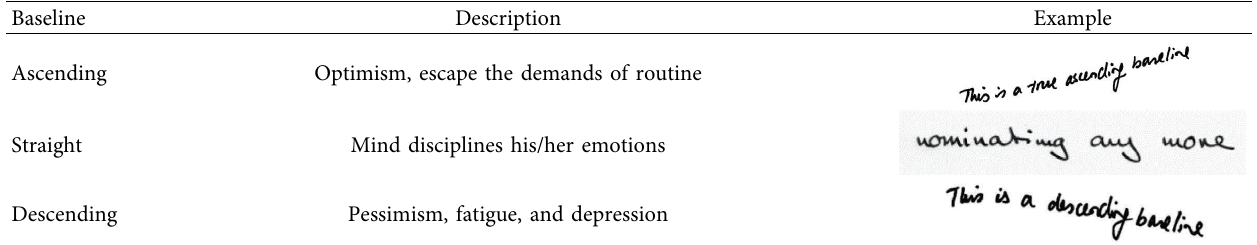
Table 2: Baseline features and their corresponding